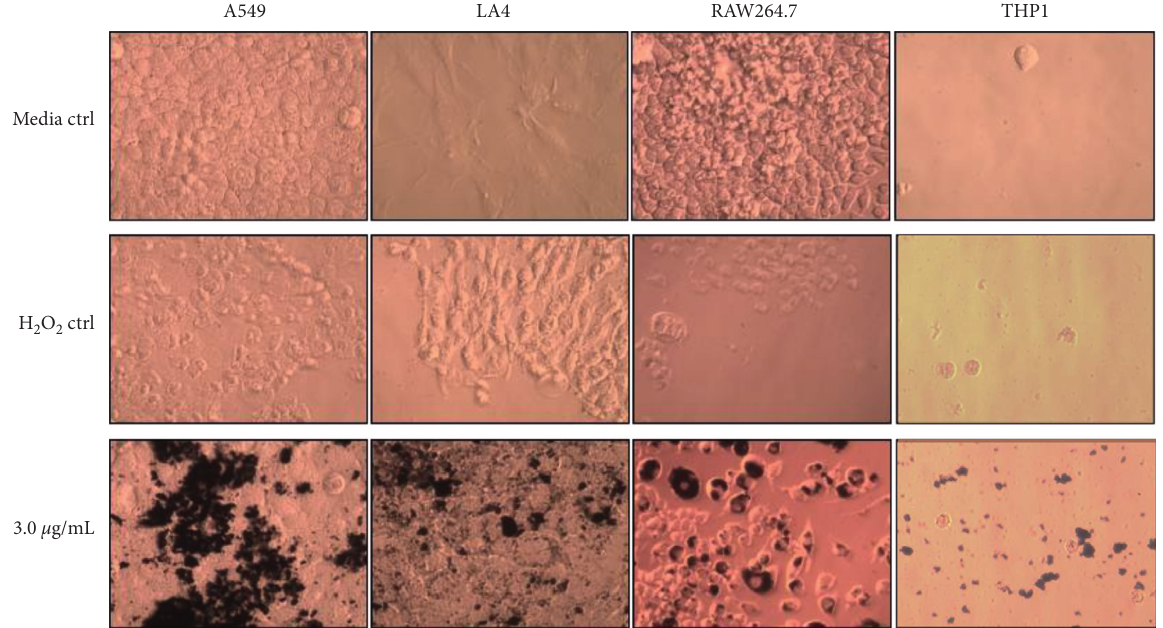
Figure 1: Low-dose UBC aggregates on the cell surface and may translocate into macrophages. Images captured upon UBC treatments after the 9-day mark across A549, LA4, RAW264.7, and THP1 cell lines. The images were digitally captured by light microscopy using a Leica Model DMIL EC3, LED and observed with LAS EZ Leica Microsystems program at a 40x magnification: media “untreated” control, 10mM H 2 O 2 control, and 3.0 µ g/mL UBC are shown across each cell type. Table 1: Percentage of cell populations displaying viable and apoptotic trends conducted via flow cytometry. PI ( − )